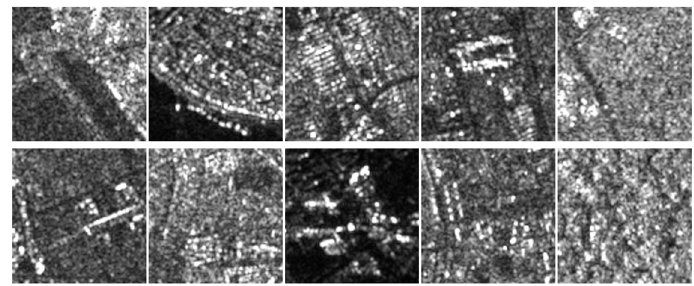
Figure 13. A sample diagram of the OpenSarUrban dataset.